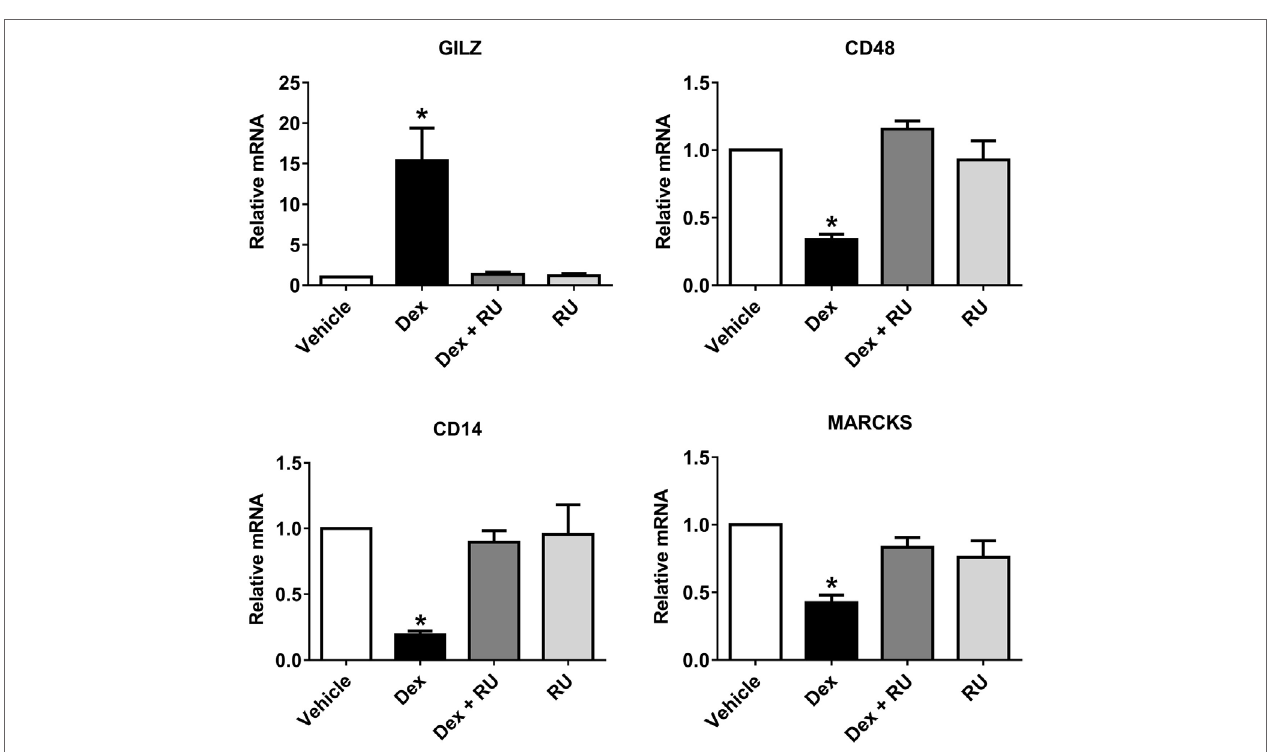
FigUre 4 | Quantitative PCR validation of Dex repressed phagocytosis-associated genes identified by microarray analysis. Three genes were selected by microarray from phagocytosis-associated genes that were also repressed by Dex: CD48 , CD14 , and MARCKS . Quantitative PCR was performed on macrophages treated with either 100 nM of Dex, 1 µM of the GC receptor inhibitory molecule RU486 or both, in order to evaluate whether the observed effects are due to GC receptor action. GILZ , a GC receptor response element, was used as positive control for GC receptor activation. One-way ANOVA and Bonferroni corrections were performed ( n = 4; p < 0.05 compared to